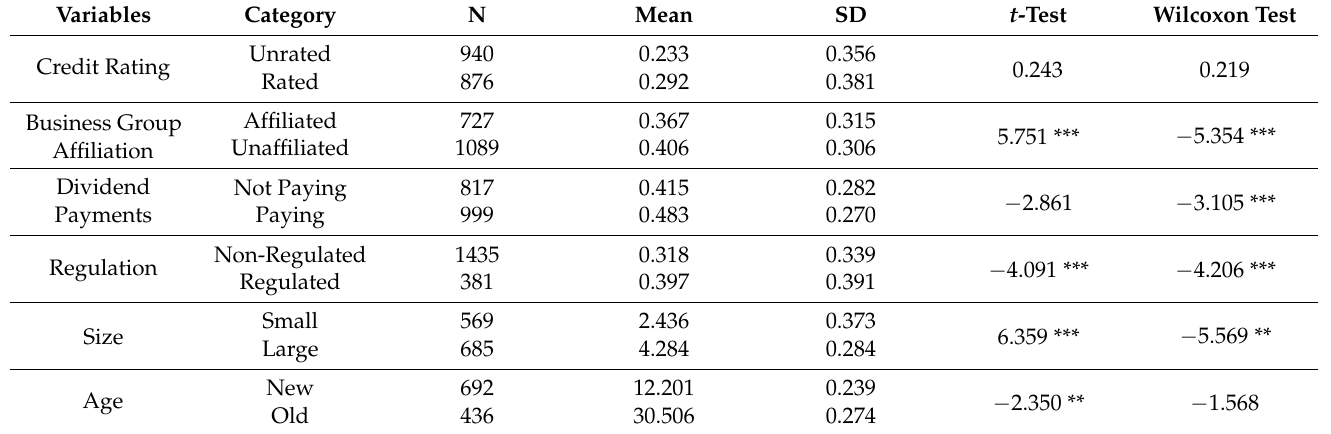
Table 5. Applicability of debt specializations strategy across